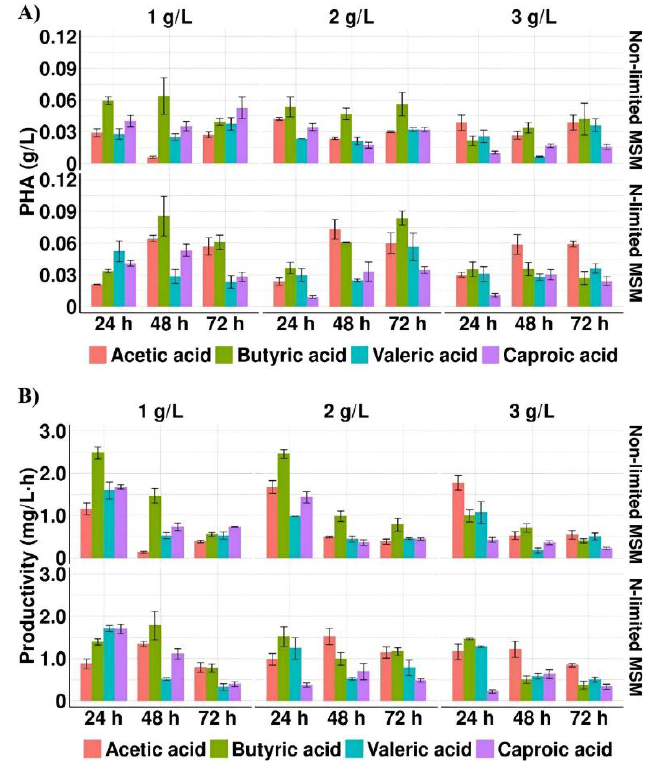
Figure 1. ( A ) PHA concentration and ( B ) PHA productivity profiles of Aeromonas sp. AC_01 cultured in the medium supplemented with individual short and medium chain fatty acids at the concentration of 1 g/L, 2 g/L and 3 g/L Abbreviations: non-limited MSM, non-limited mineral salt medium; N-limited MSM, nitrogen limited mineral salt medium.